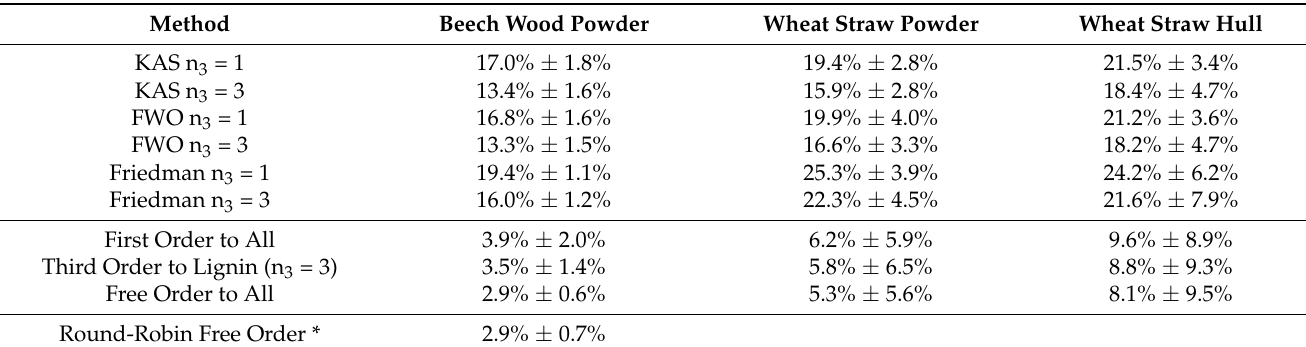
Table 11. Derivative RMSE of the curves produced using kinetics determination methods in simulta- neous comparison with all experimental d α /dt curves. Confidence interval of